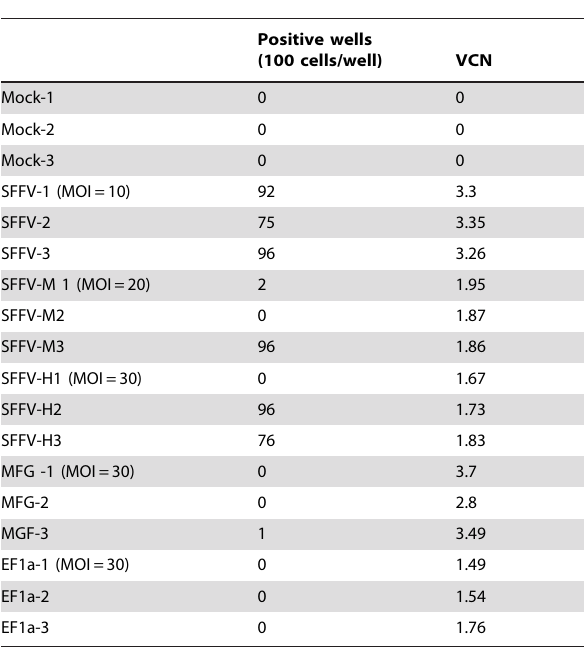
Table 5. Myeloid immortalization